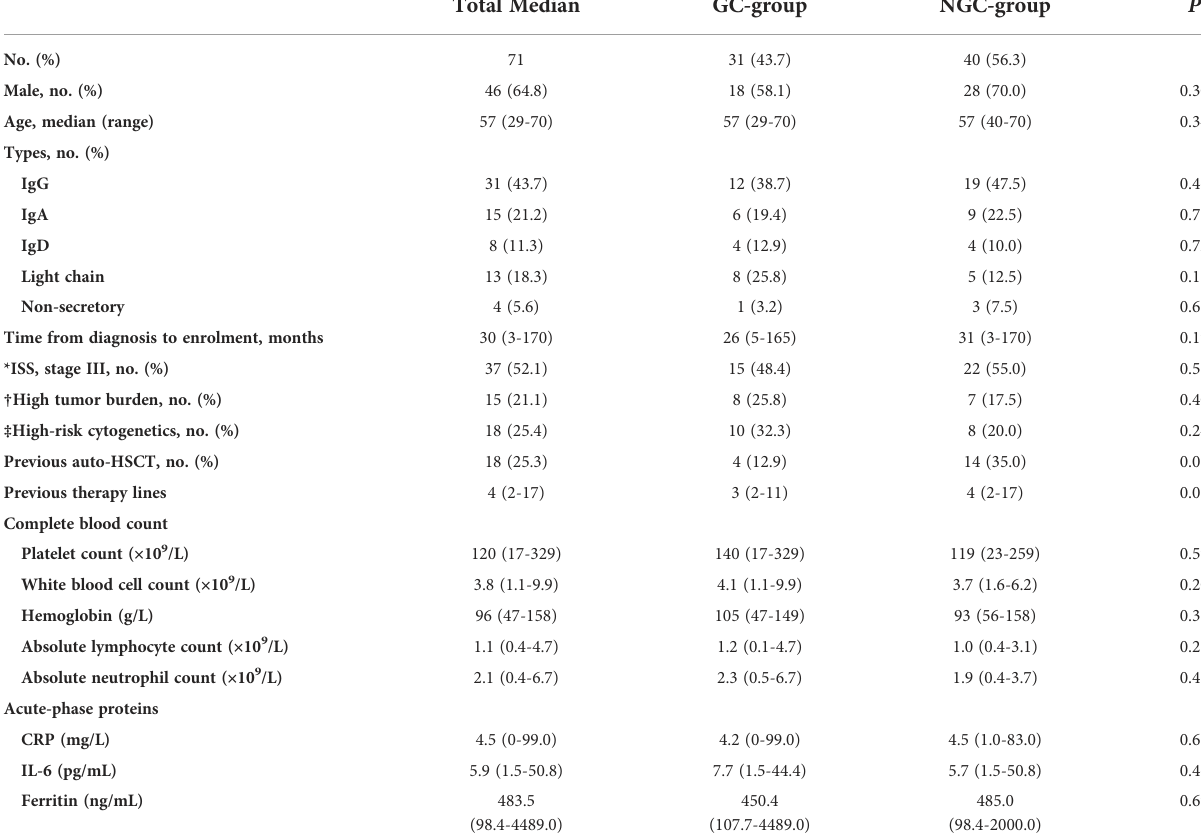
TABLE 1 Baseline characteristics and association with GC